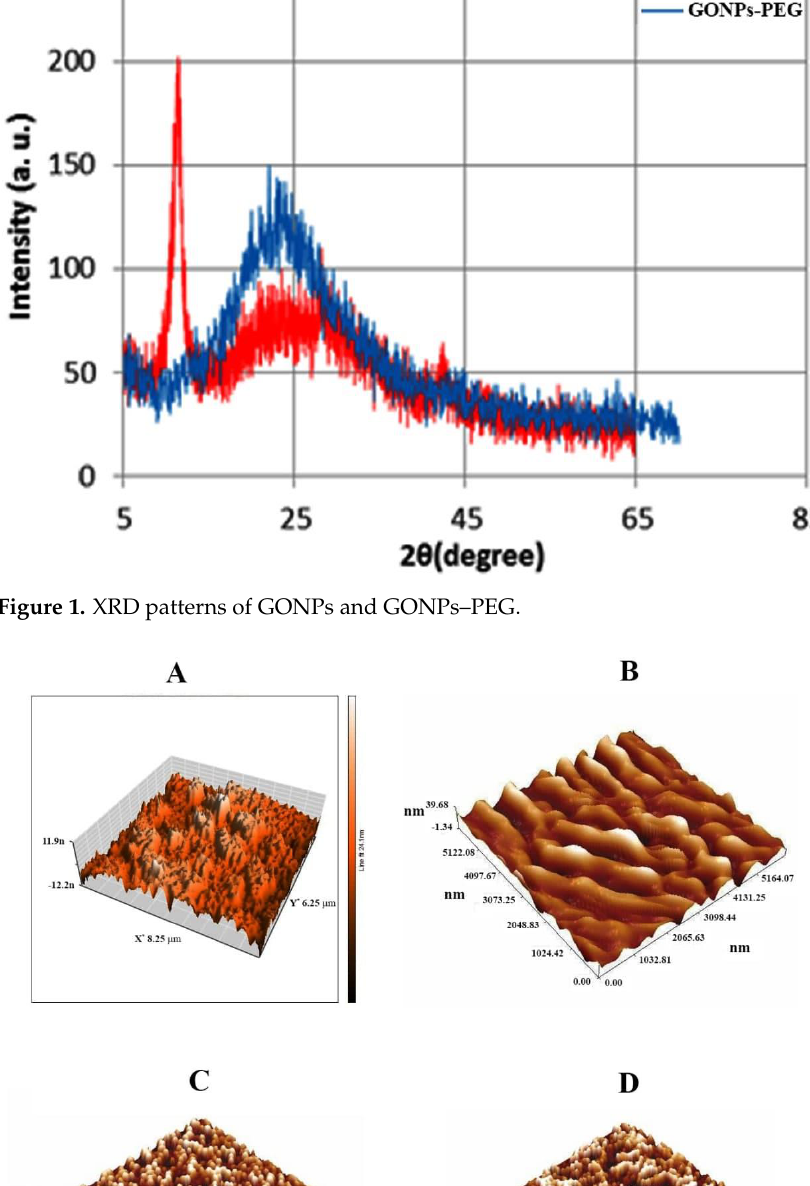
Figure 3. TEM images of ( A ): GONPs, ( B ): GONPs-PEG, ( C ): N. sativa and ( D ): GONPs-PEG- N. sativa .